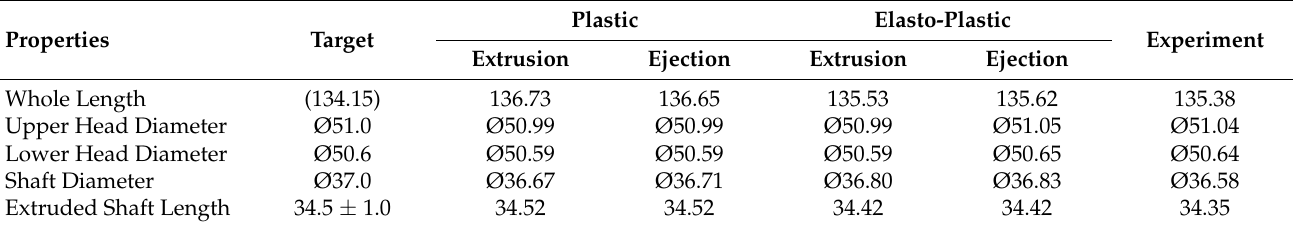
Table 5. Summary of dimensional compatibility of preform obtained through forward extrusion and ejection operations (unit: mm).